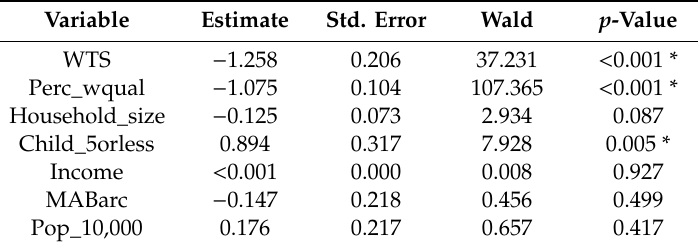
Table 4. Ordinal regression model 1 results.